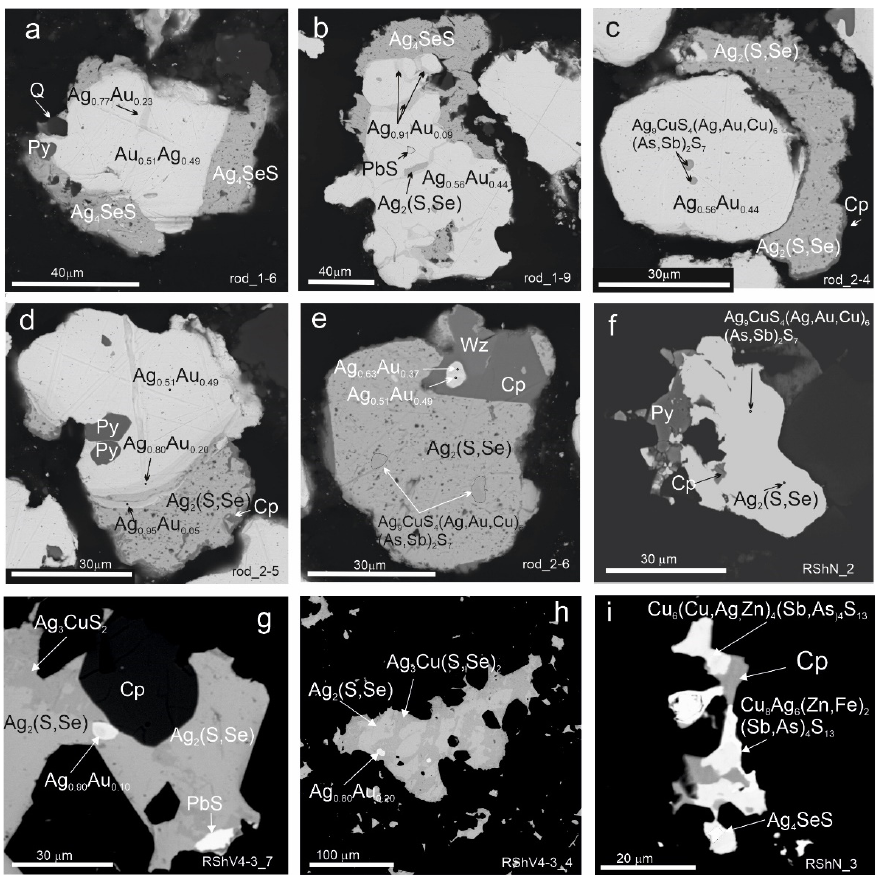
Figure 5. SEM-BSE images of ore concentrates from the Rodnikovoe deposit. The silver-aguilarite- acanthite assemblage: ( a – d ) Electrum (Au-Ag) grains bordered by aguilarite (Ag 4 SeS) or Se-acanthite [Ag 2 (S,Se)], including veins and borders of Ag-rich alloy ( a , b , d ) and inclusions of galena (PbS) ( b ), pyrite (Py) ( a , d ), and pearceite Ag 9 CuS 4 (Ag,Au,Cu) 6 (As,Sb) 2 S 7 ( c ); ( e ) acanthite grain with inclusions of pearceite, intergrown with chalcopyrite (Cp) and wurtzite (Wz); ( f ) intergrowth of acanthite-pyrite and inclusions of pearceite; ( g , h ) replacement texture of acanthite by jalpaite Ag 3 CuS 2 with inclusions of native silver and galena; ( i ) Ag,Zn-tetrahedrite Cu 6 (Cu,Ag,Zn) 4 (Sb,As) 4 S 13 and Cu 8 Ag 6 (Zn,Fe) 2 (Sb,As) 4 S 13 intergrown with chalcopyrite and inclusion of